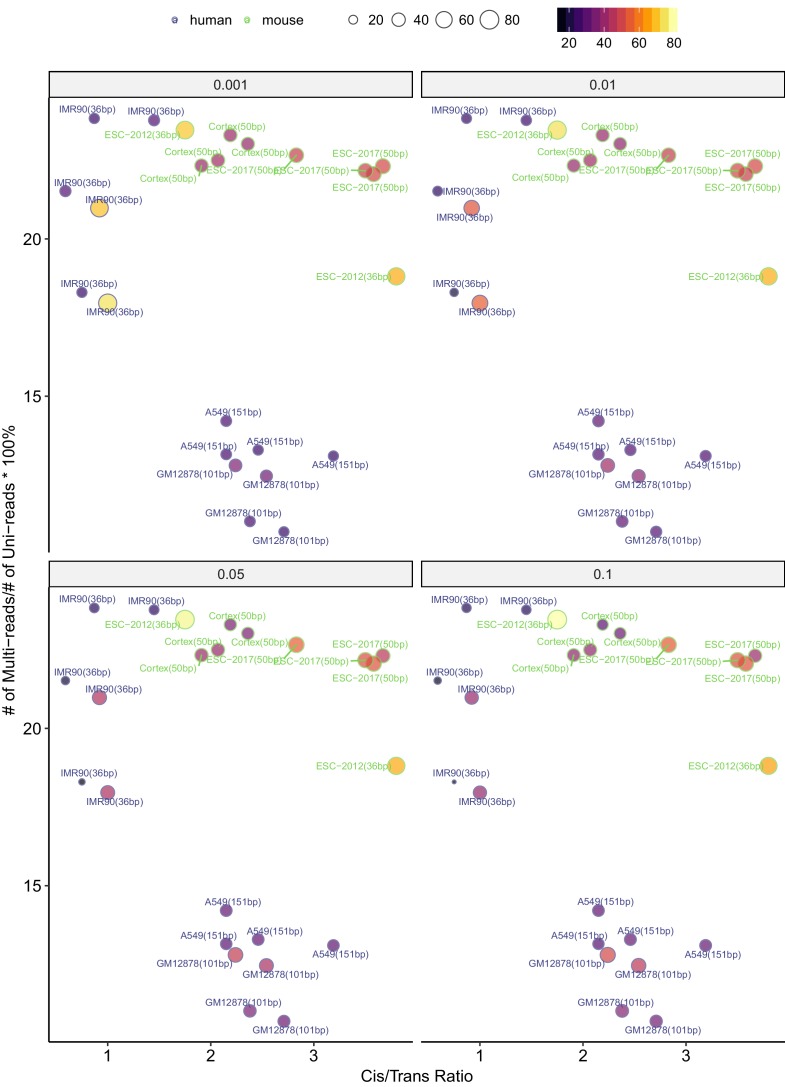
Percentage change in the numbers of significant interactions as a function of the percentage of mHi-C rescued multi-reads in comparison to uni-reads and cis-to-trans ratios at 40 kb.